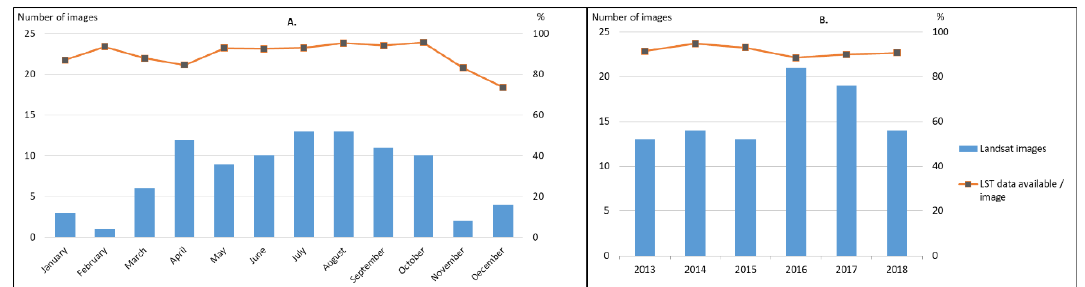
Figure 5. Absolute and relative frequencies of Landsat 8 LST images and data available over the study area through 2013–2018: monthly ( A ) and annual ( B ) statistics.